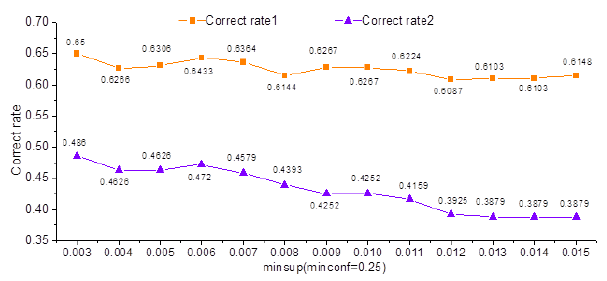
Fig. 7. The predicted result of the trajectory with the id number of 126. The black part is the current trajectory for predicting; the blue part is the actual future trajectory for verifying; The red part is the predicted trajectory by data mining.